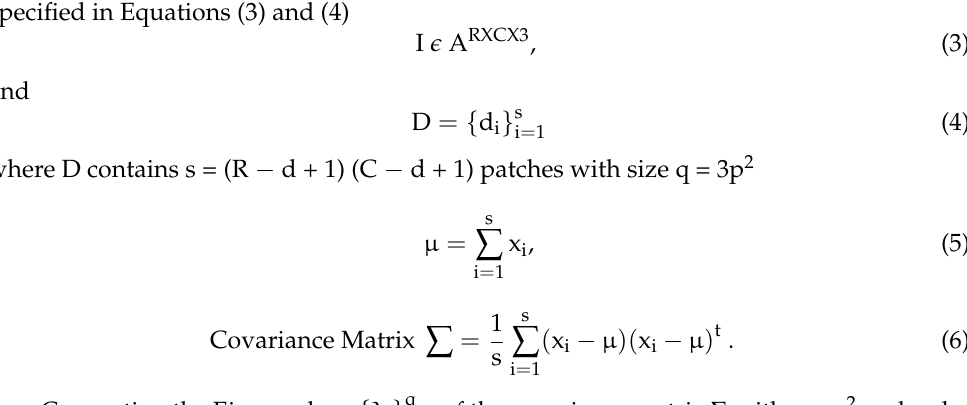
Figure 3. Visual representation of pixel matching